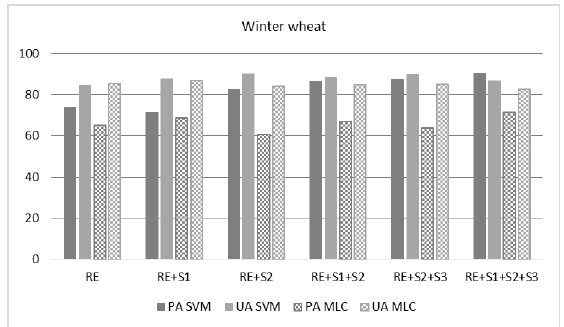
Figure 2. Producer´s and user´s accuracies for winter wheat for all image combinations